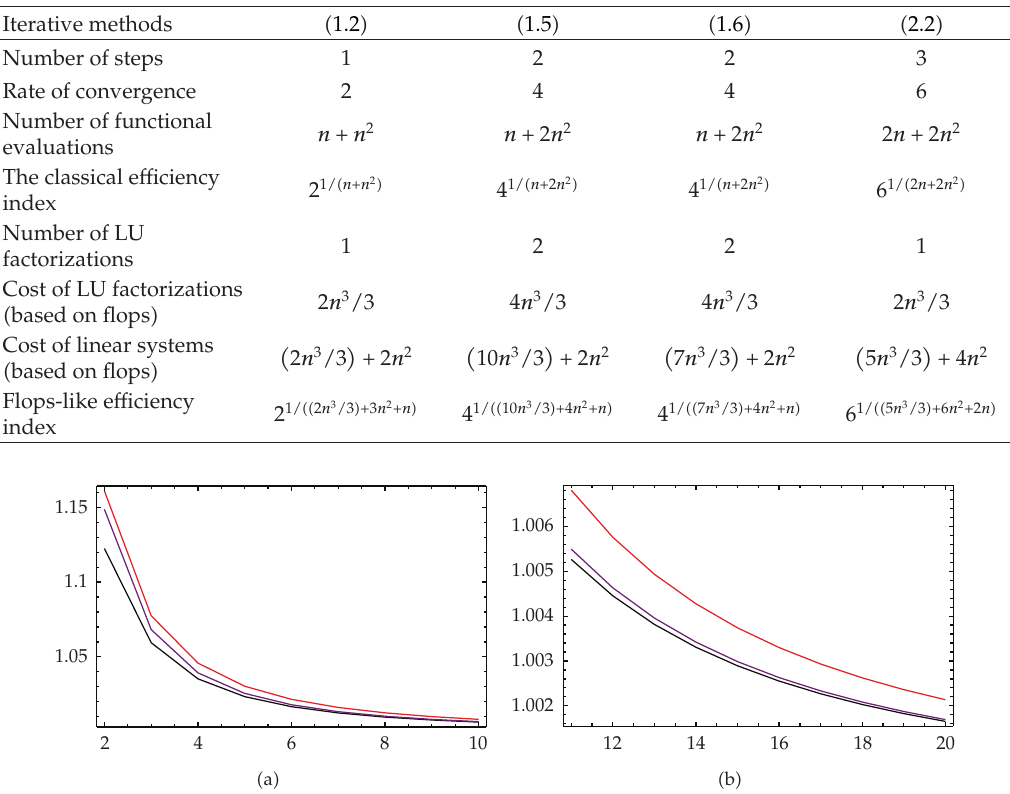
Table 1: Comparison of e ffi ciency indices for di ff erent methods.